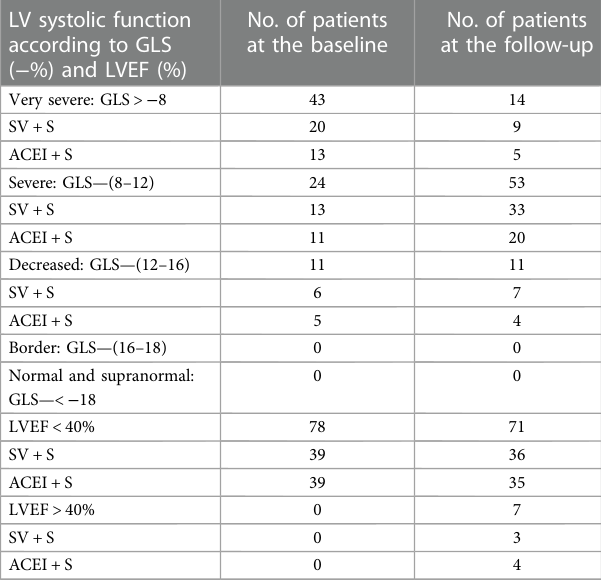
study. LV systolic function according to